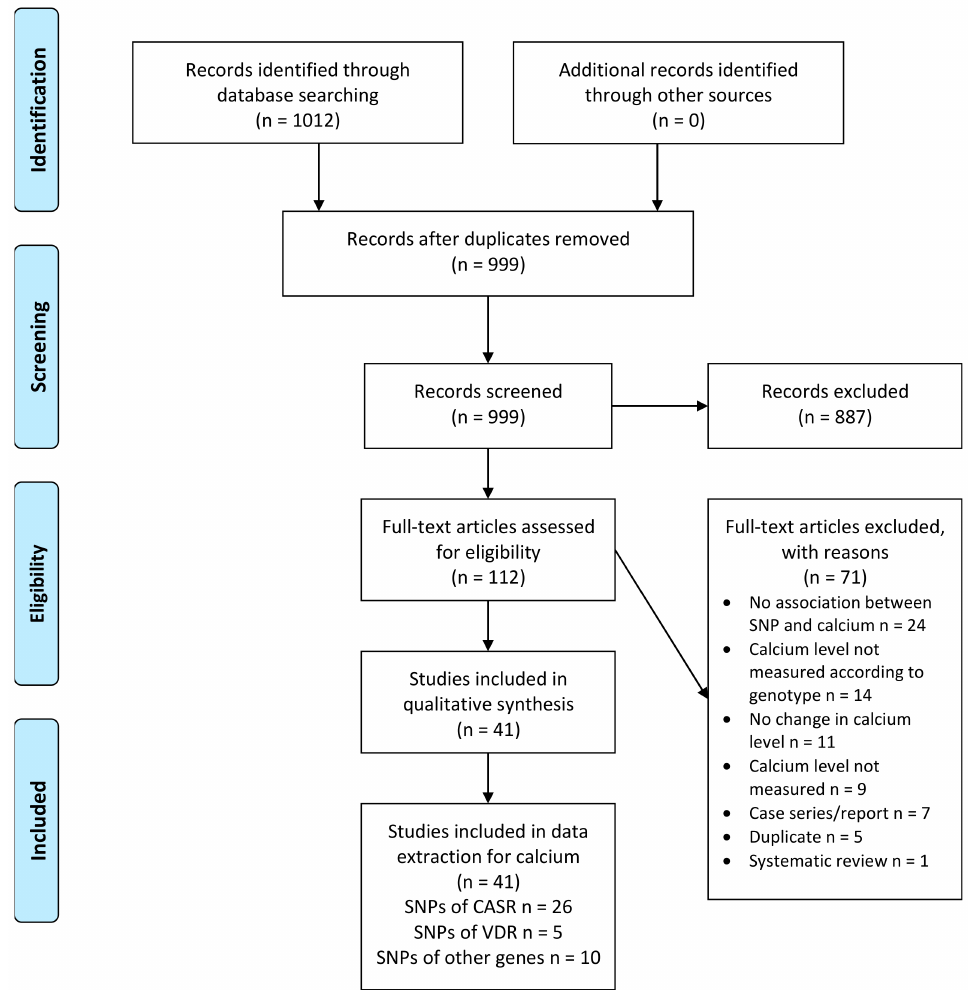
Figure 1. Study flow diagram. Abbreviations: CASR: calcium-sensing receptor; SNP: single nu- cleotide polymorphism; VDR: vitamin D